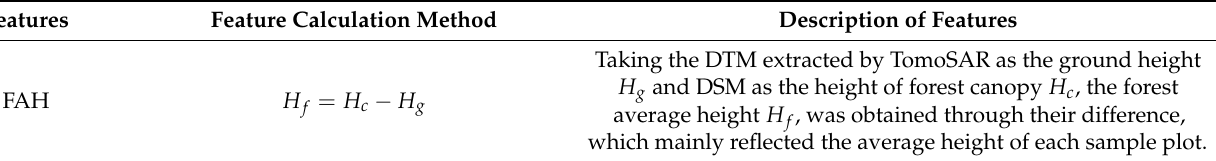
Table 3. Definition of the features extracted from TomoSAR forest vertical